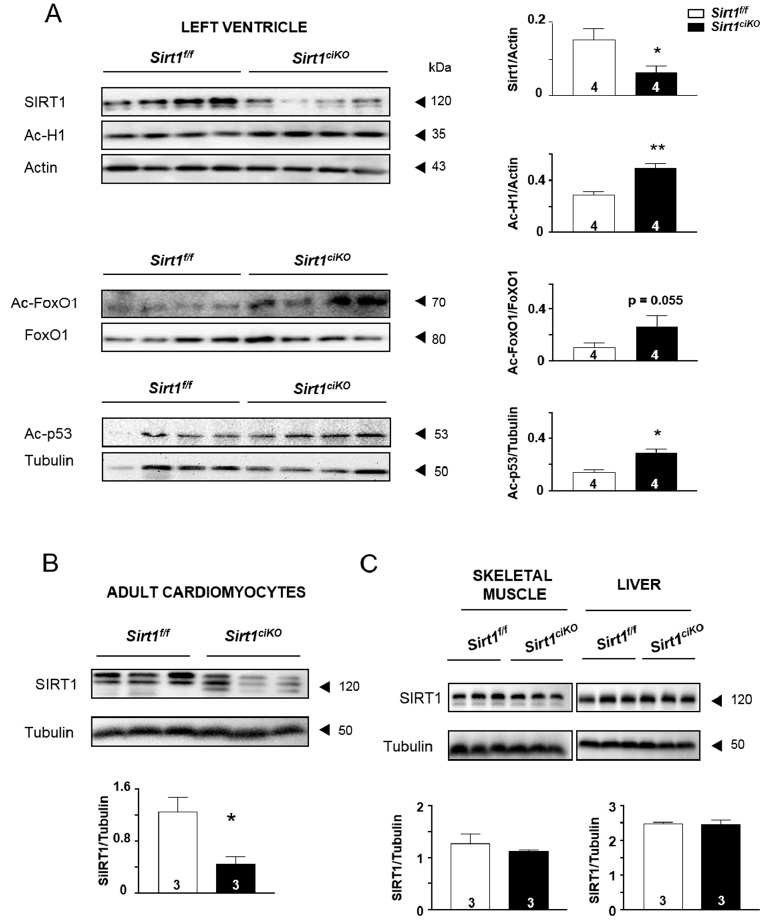
Figure 1. Cardiac-specific Sirt1 inactivation in adult mice 4 weeks after tamoxifen injection. ( A ) Protein content of SIRT1 and its downstream acetylated targets (acetylated-Histone H1 (Ac-H1),